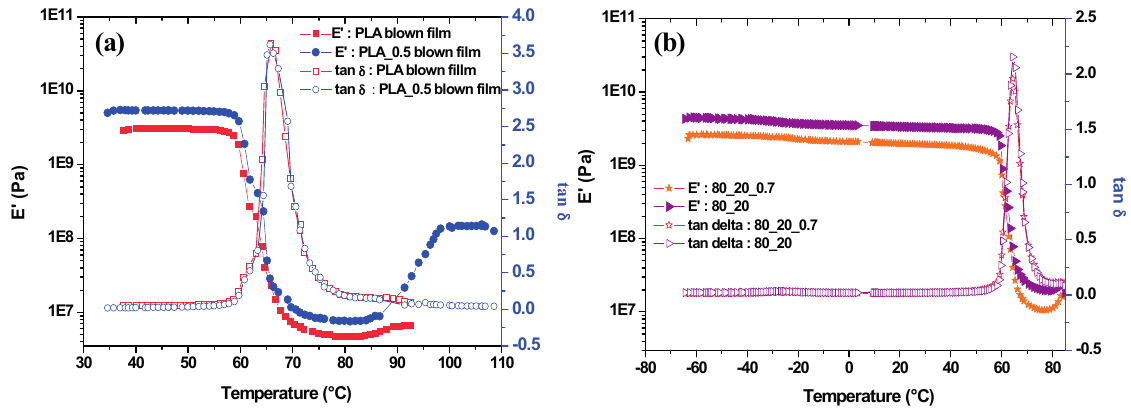
Figure 17. Storage modulus and loss factor evolution versus temperature for ( a ) PLA and PLA–0.7 and ( b ) PLA–PBAT